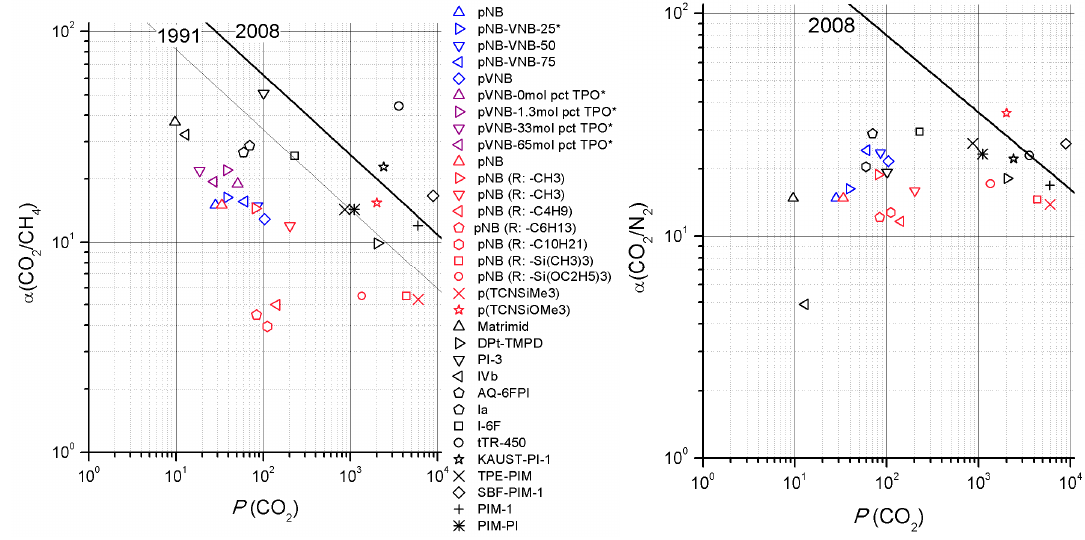
Figure 11. ( Left ) CO 2 / CH 4 and ( Right ) CO 2 / N 2 Robeson plots with polynorbornenes with increasing VNB content (blue), pVNB with increasing TPO loading (purple), other polynorbornenes (pink) and polyimides, PIMs and thermally rearranged polymers (black). * Single-gas P CO2 data [Barrer] obtained using Equation (3). Data obtained from [7,9,15,28,34–44]. Upper bound data was taken from